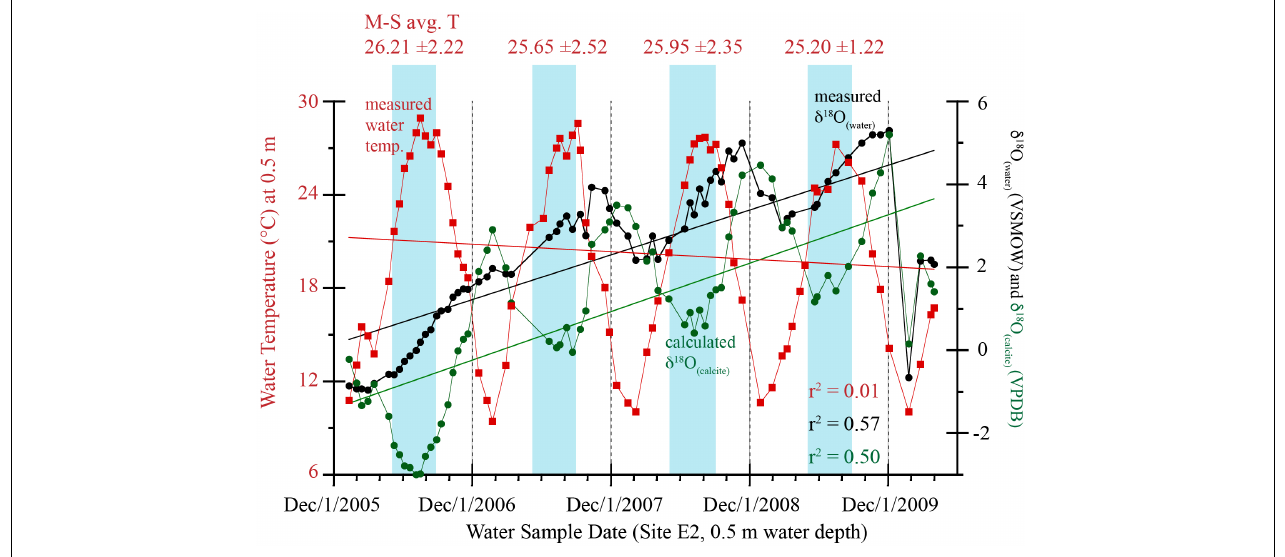
FIGURE 7 | Lake Elsinore measured δ 18 O ( lakewater ) values, measured water temperature (0.5 m water depth), and δ 18 O ( calc . sed . calcite ) . Shaded areas represent months of peak calcite precipitation. Average May (M) – September (S) lake water temperatures are shown at the top of the figure with standard deviation values.